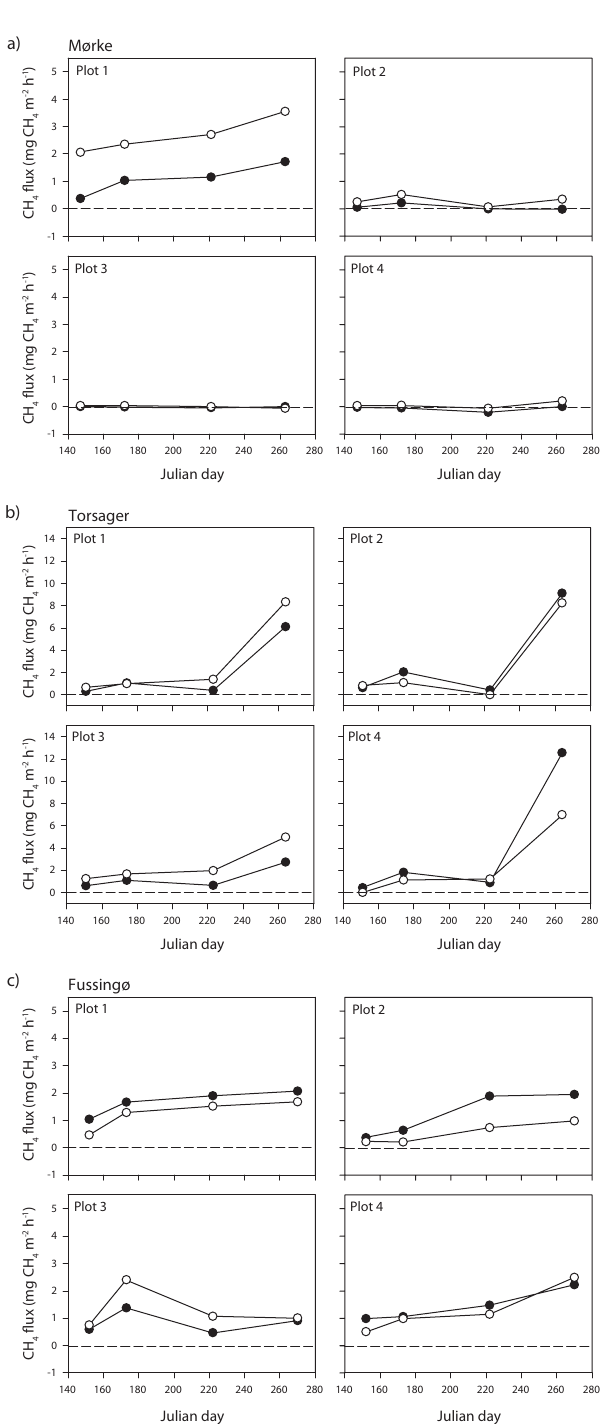
Figure 4. Methane (CH 4 ) fluxes at paired sampling quadrats with (- ◦ -) and without (- • -) Juncus effusus at the three different sites (Mørke, Torsager and Fussingø) at the four samplings dates. Note the different y axis scale in (b)